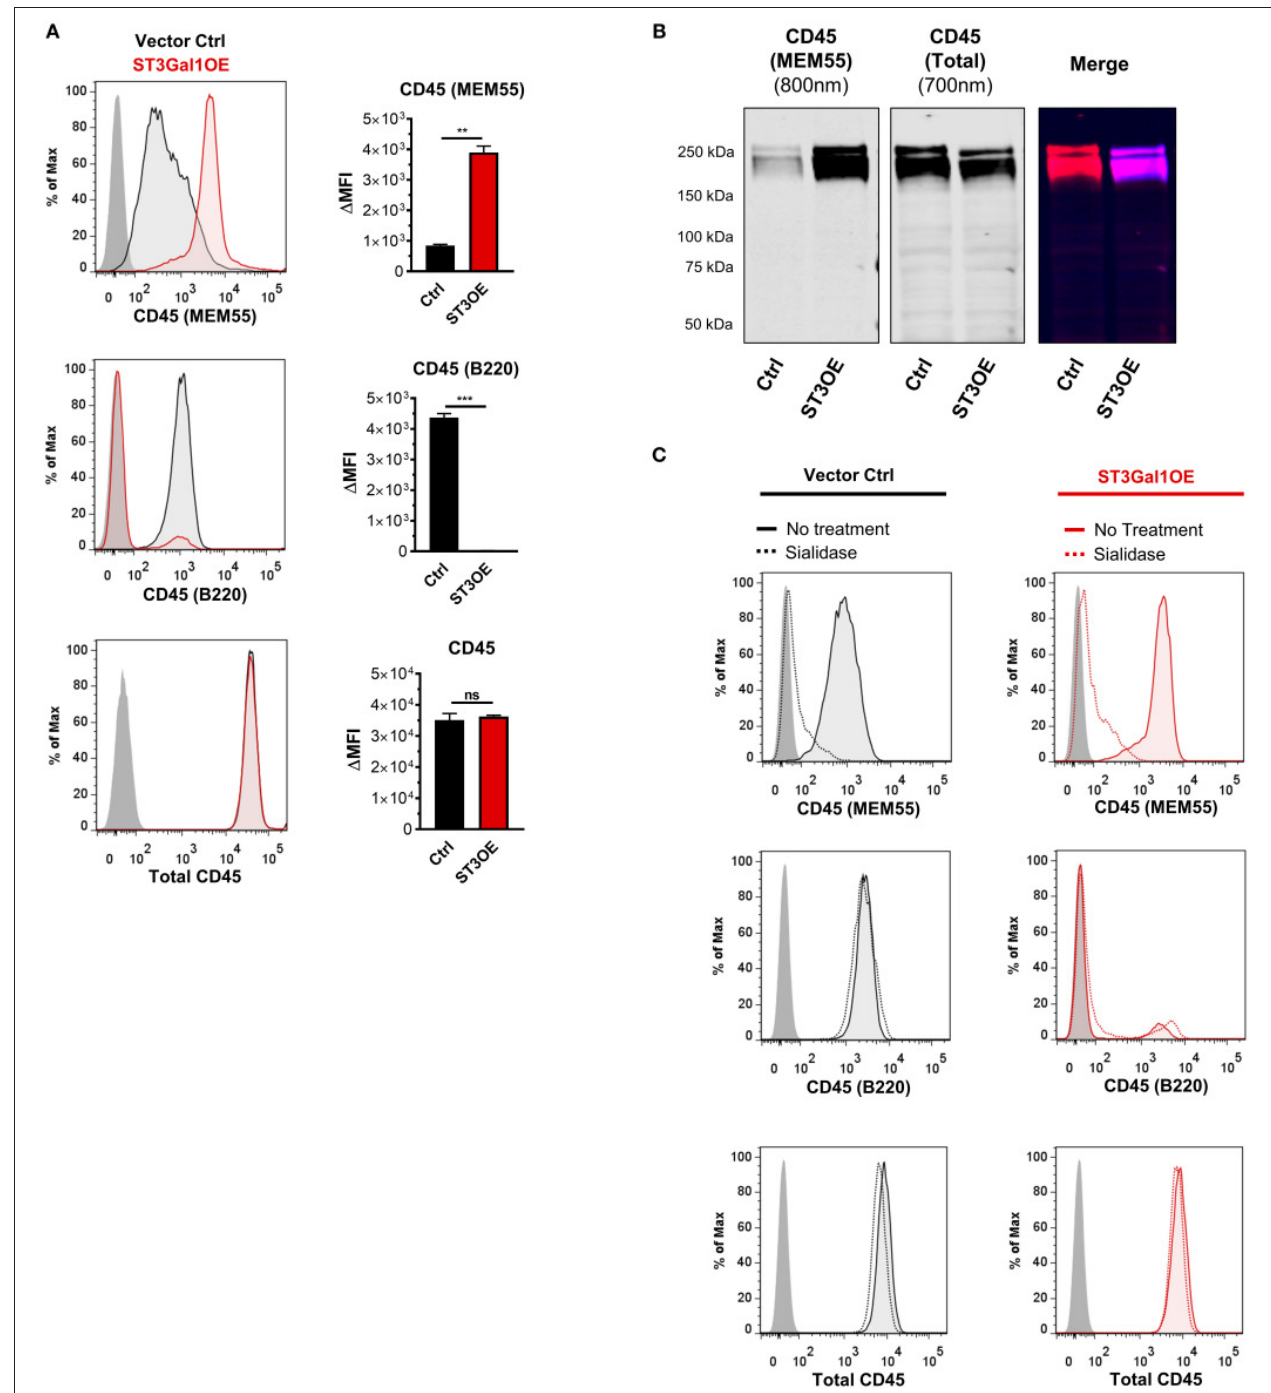
FIGURE 4 | Overexpression of ST3Gal1 in B cells modulates binding of glycosylation sensitive CD45 antibodies. (A) Representative histogram ( left ) and quantification ( right ) of binding of two glycosylation-sensitive CD45 antibodies (MEM55 and B220) and one glycosylation-insensitive antibody (total CD45, clone HI30) to vector control and ST3Gal1OE Ramos B cells by flow cytometry. (B) Western blot analysis of binding of CD45 mAb MEM55 (800nm fluorescence channel) and CD45 mAb HI30 (700nm fluorescence channel) to Ramos vector control and ST3Gal1OE lysates. (C) Representative histograms depicting flow cytometric analysis of CD45 antibody binding to vector control and ST3Gal1OE Ramos B cells, before and after treatment with Arthrobacter ureafaciens sialidase. Data in (A,C) are from three independent experiments with three biological replicates. Data in (B,C) are representative of similar results from three (B) or two (C) independent experiments. Statistics in (A) were calculated using Welch’s unpaired, two-tailed t -test. Throughout, bars and error bars depict the mean and SEM, respectively. ns, not significant, ** p ≤ 0.01, *** p ≤ 0.001, 1 MFI, background subtracted geometric mean fluorescence intensity; Ctrl, vector control; ST3OE, ST3Gal1OE.